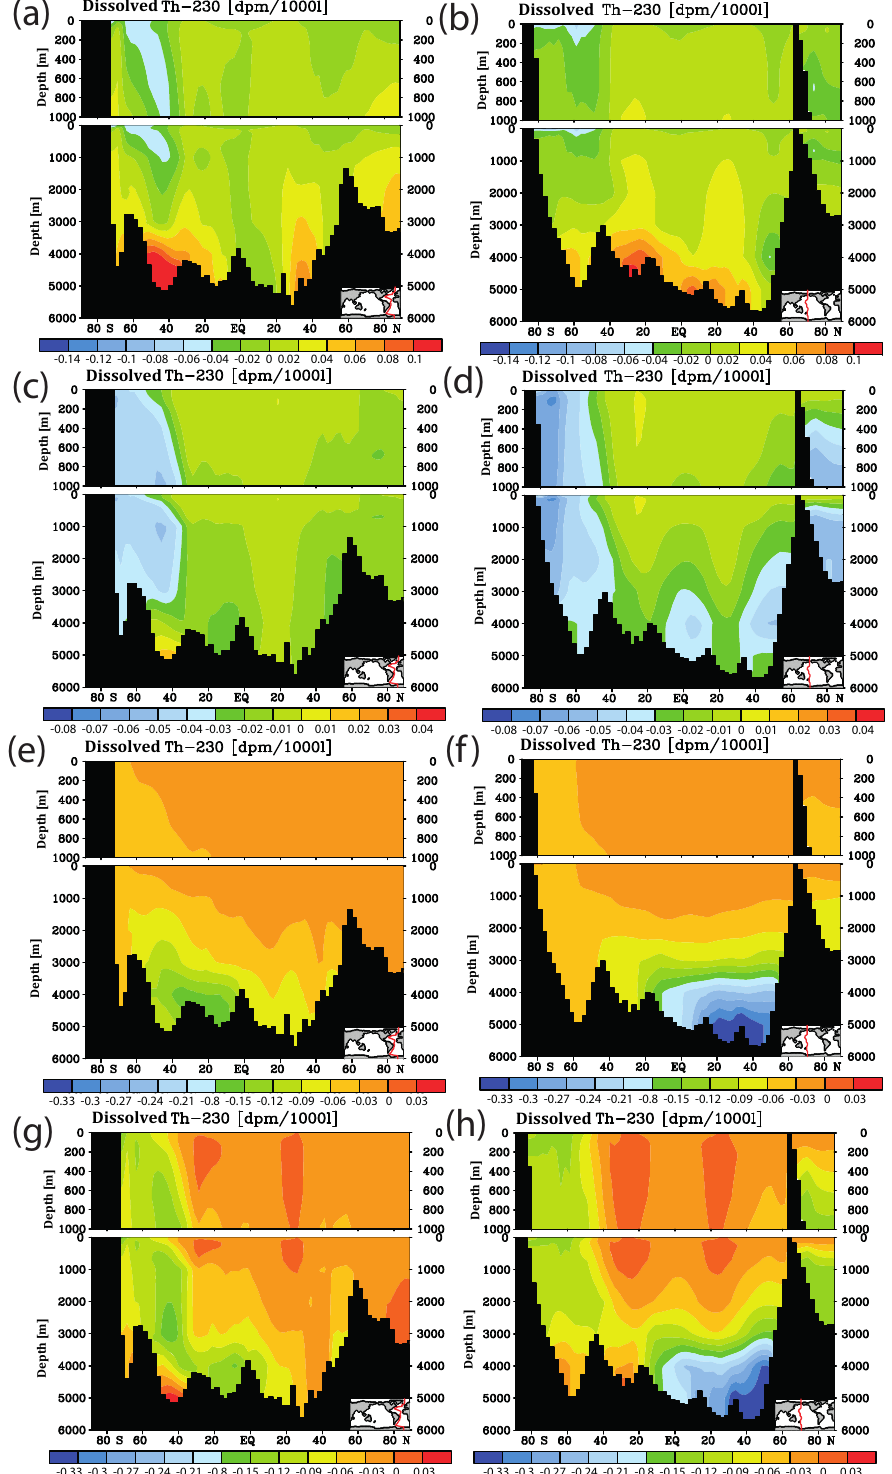
Figure 11. Meridional cross sections for sensitivity experiments concerning the projections including a representation of interannual/decadal variability. Shown are differences in dissolved 230 Th for forcing relative to the normal run with RCP8.5 and the moderate calcification scenario for the year 2050. (a) Change in velocity field (for details, see the text). (b) As (a) but for the Pacific. (c) Change of V max for phosphate uptake (for details, see the text), Atlantic. (d) As (c) but for the Pacific. (e) Change of the sinking velocity of particulate matter (for details, see the text). (f) As (e) but for the Pacific. (g) Simultaneous change of velocity field, V max , and sinking velocity. (h) As (g)